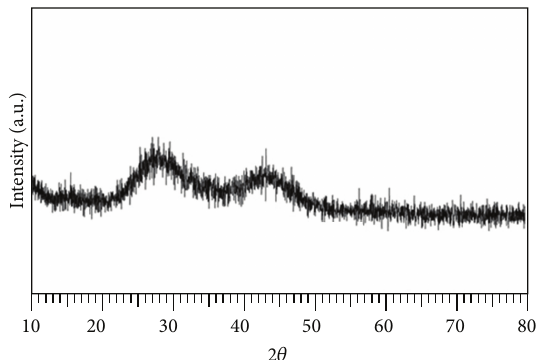
Figure 2: XRD pattern of composition [30%K 2 CO 3 + 70%H 3 BO 3 ], glass